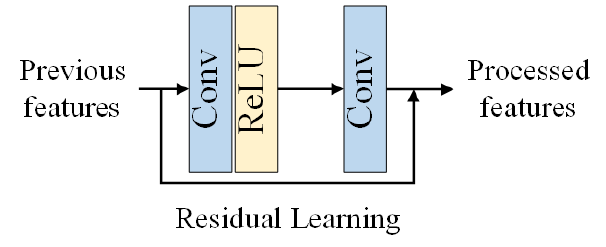
Figure 4. The Enhanced Residual Block (ERB).